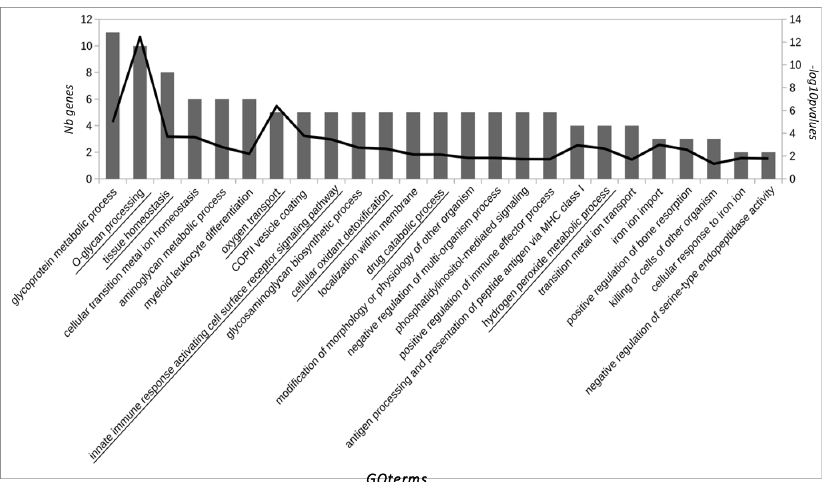
Figure 1. GO terms over-represented in the pool of significantly expressed saliva proteins in horses with AAD. GO terms are ordered by the number of significant genes/proteins of the study associated with them according to the Gene Ontology database (first y-axis). The −log10 of p-value for each GO term is represented on the second y-axis. GO terms which define a group of similar GO terms (determined by ReviGO) are in bold.